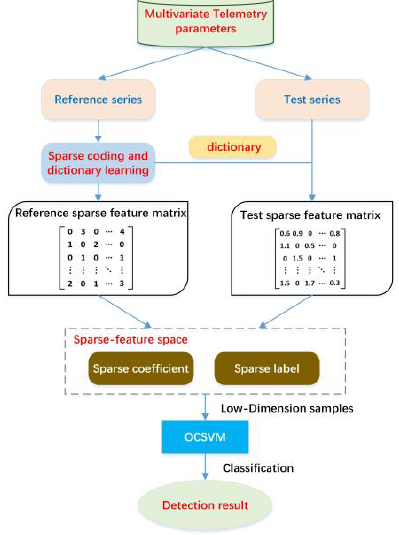
Figure 2. Flowchart of the SFAD method for spacecraft anomaly detection.